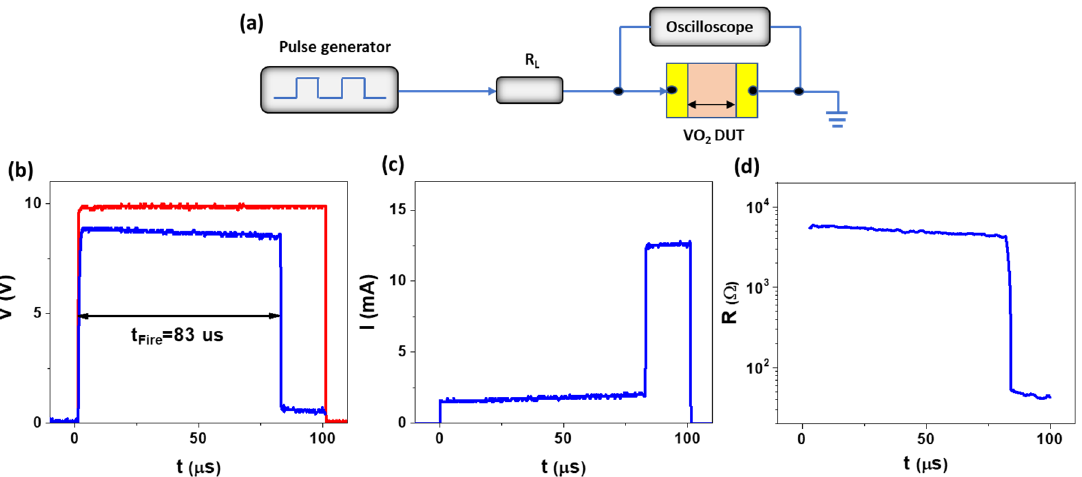
Figure 2. ( a ) Schematic of the circuit used to test VO 2 devices. An example of VO 2 IMT stimulated by a 10 V pulse of 100 µs time duration: ( b ) applied voltage (red curve) and measured device voltage (blue curve), measured device current ( c ) and resistance ( d ), during a 100 µs pulse.